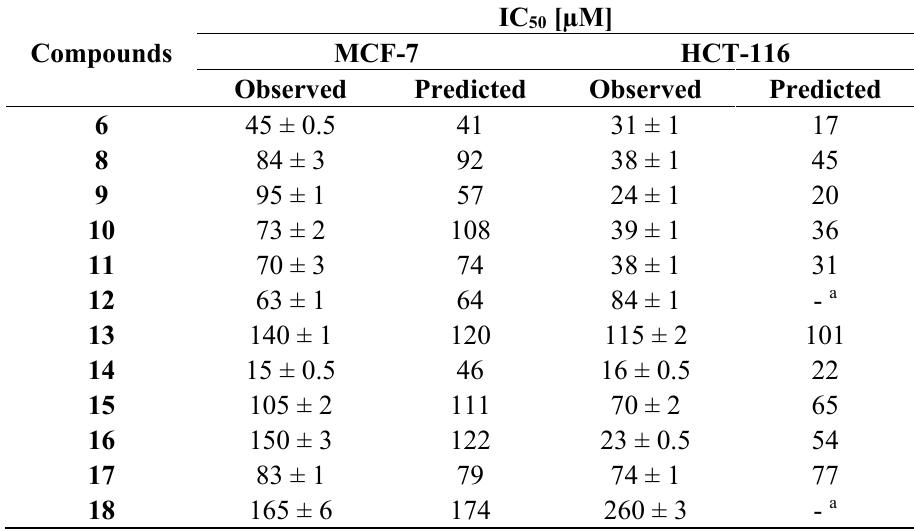
Table 5. The cytotoxic activity against MCF-7 and HCT-116 obtained from experiments (observed) and from statistical calculations